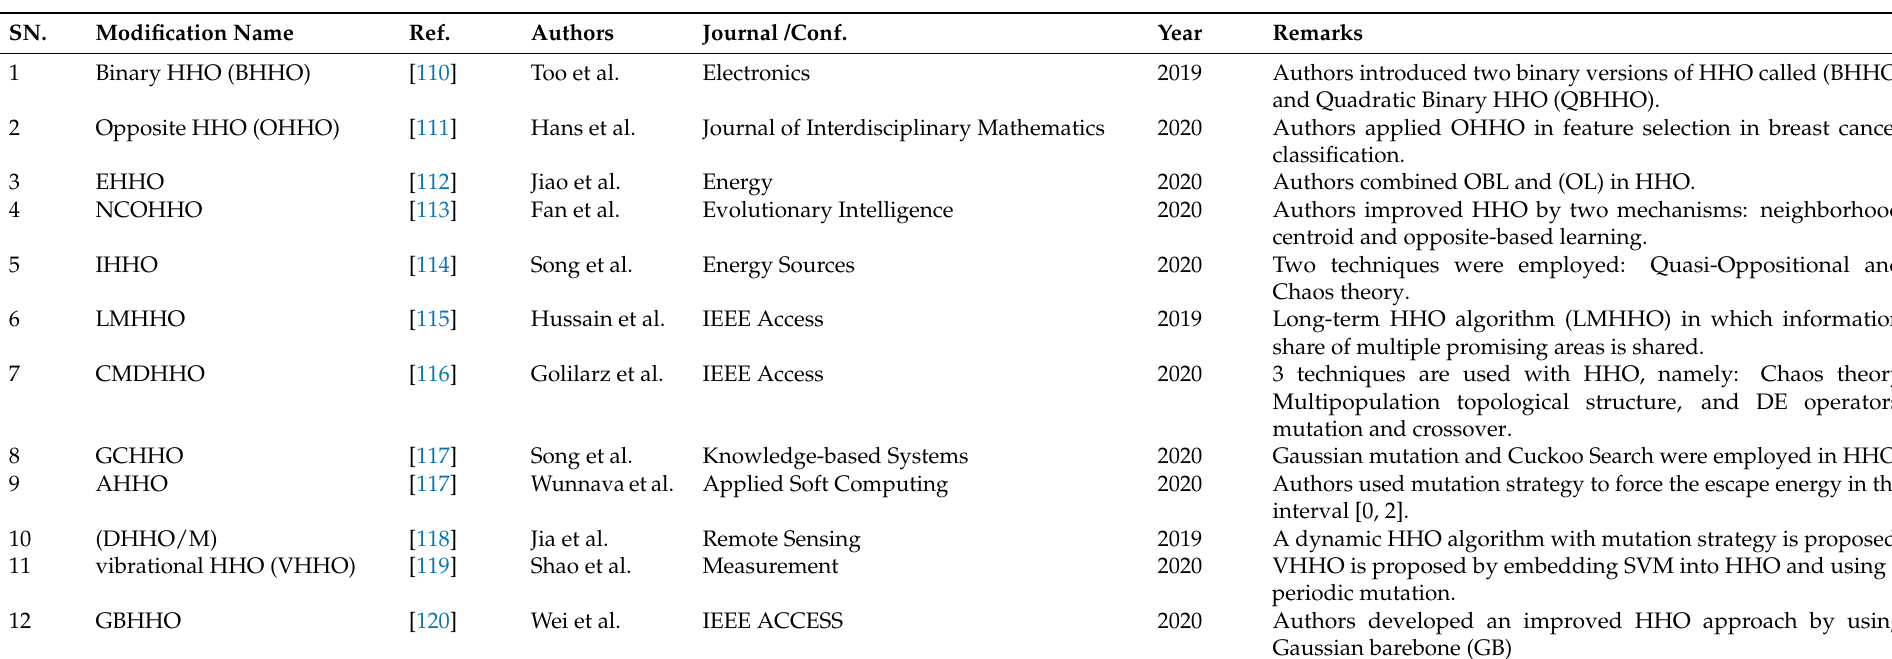
Table 7. Summary of literature review on variants and modified HHO